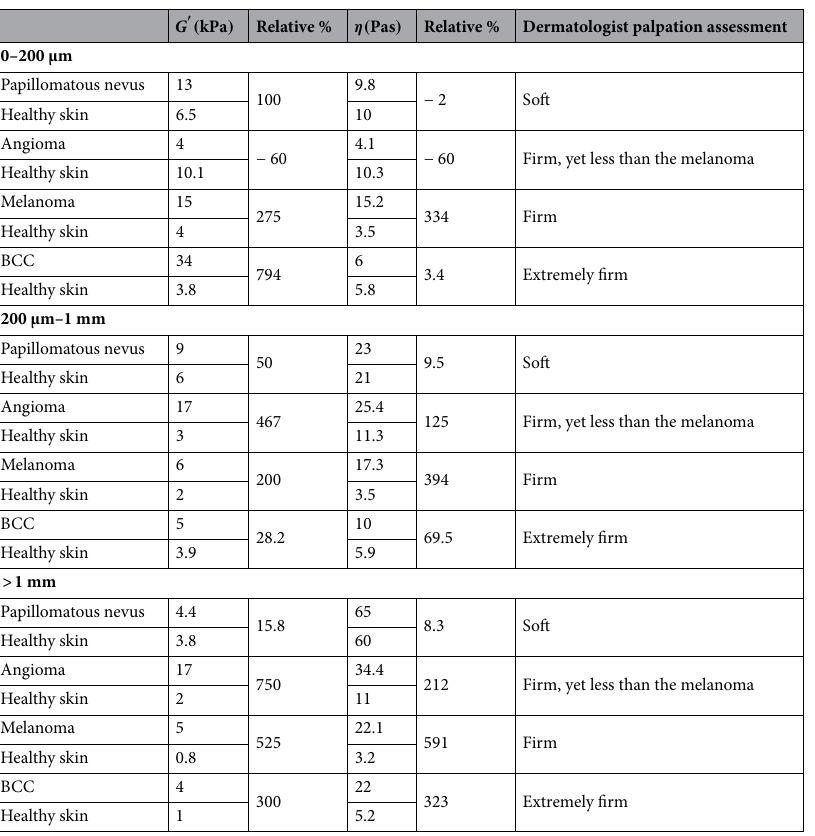
Table 1. Viscoelastic outcomes of the measured melanoma, Angioma, BCC, and Papillomatous Nevus including storage modulus relative percentage calcutated over the tumor and healthy skin results G ′ ( HealthySkin ) G ′ ( tumor ) , viscosity relative percentage calculated over the tumor and healthy skin results − G ′ ( HealthySkin ) η ( HealthySkin ) η( tumor ) , and dermatologist’s palpation − η ( HealthySkin )